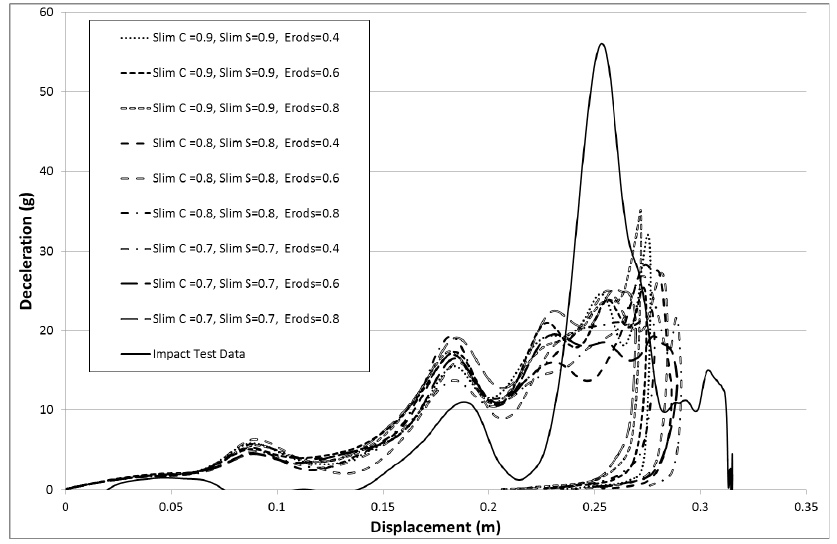
Figure 22. Effect of Slim C, Slim S and Erods parameters with Slim T = 0.1, TSize = 1 × 10 − 11 , Soft = 0.0 and FS = − 1.0.